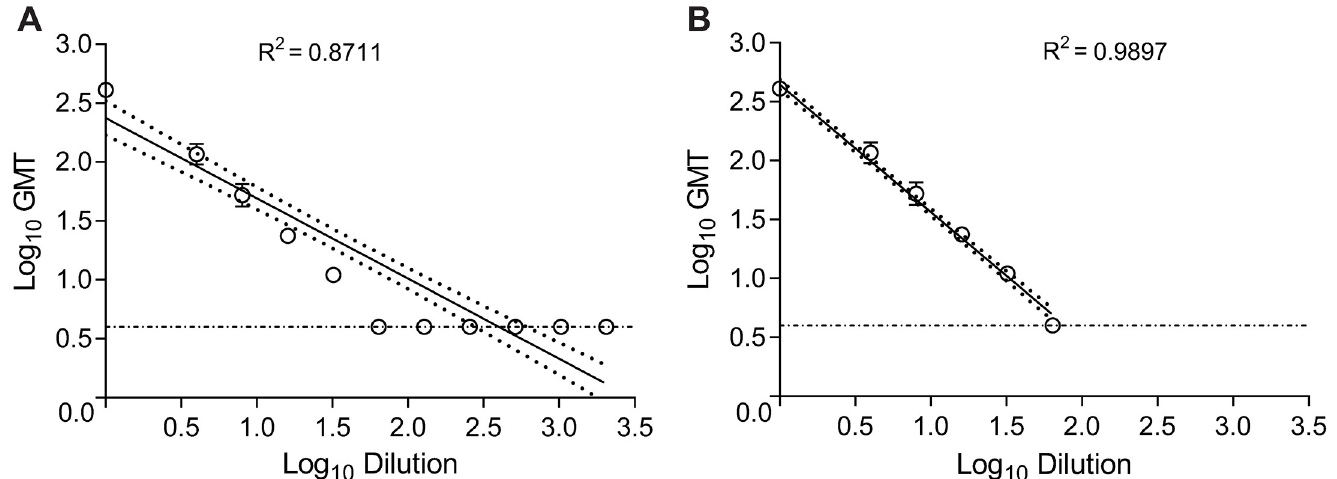
Fig 4. Linearity of MN-RT-qPCR assay. The linearity of MN-RT-qPCR assay was assessed by testing 10 samples with varying measles antibody concentration. All samples were tested in duplicate in two independent assays. The GMT titers were plotted using the log of the GMT for each sample versus the log of the reciprocal dilution and a correlation coefficient calculated. Each symbol represents the GMT ± standard deviation for each sample (N = 4). The horizontal dashed line represents the limit of detection of log 10 0.60 (titer of 4). The best fit line and 95% confidence bands are represented by the solid and dotted lines, respectively. The GMT for the undiluted sample was based on a back-calculation of all the diluted